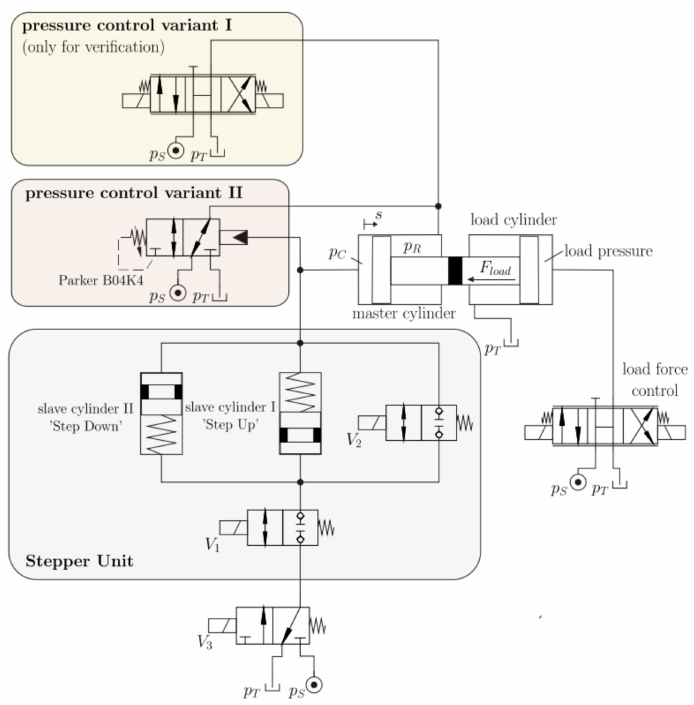
Figure 23. Schematic of the hydraulic circuit for two variants of the proposed pressure compensation definition. Variant I with an active proportional valve. Variant II with a passive pressure regulator